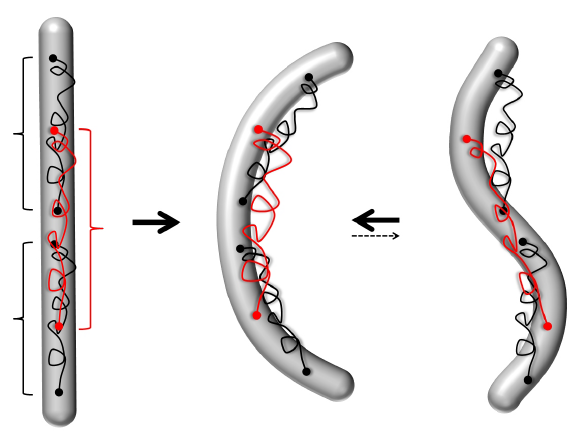
Figure 11. A semiflexible filament with elastic tails that cross-link points along its backbone becomes bistable. If the cross-linking point intervals overlap in addition (red and black chains), the curvature switching becomes cooperative. The single arc state in the middle is the energetically most stable (indicated by bold and dashed